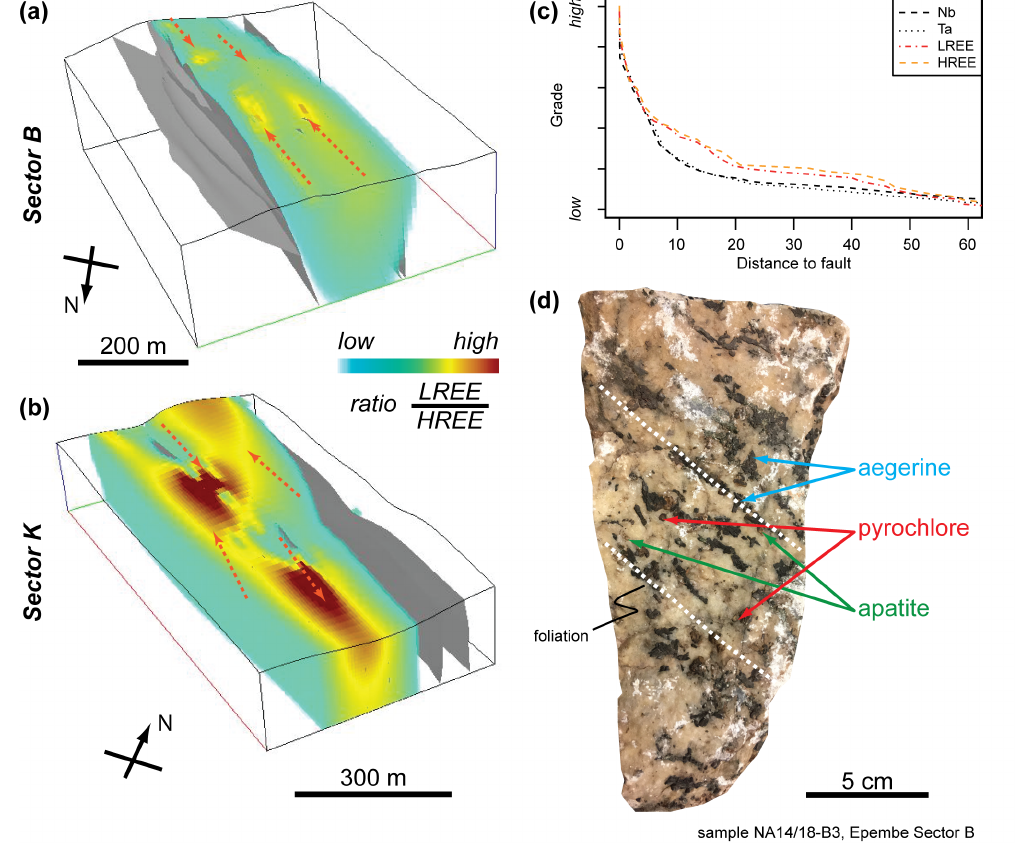
Figure 6. Ratio of Light to Heavy Rare Earth Elements (LREE/HREE) for ( a ) Sector B and ( b ) Sector K showing the decoupling of LREE and HREE enrichment within the dyke. LREE enrichment is focused in certain lenses close to faults. This provides circumstantial evidence in favor of a predominantly hydrothermal component during the enrichment phase. ( c ) Statistical evaluation of grade vs. distance to fault shows the high spatial correlation between ore-emplacement and shear zones. Visualized are the grades of Nb + Ta and REE for available data in Sectors B and K. ( d ) Sample NA14/18-B3 from Sector B shows the co-occurrence of pyrochlore and apatite in a deformed